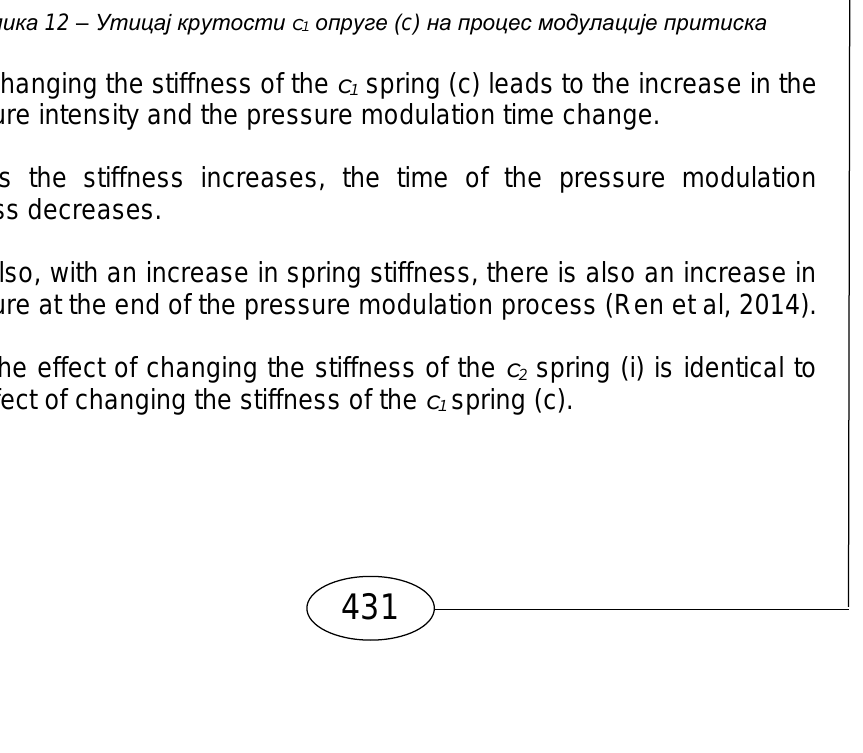
Figure 12 – The influence of the stiffness of the c 1 spring (c) on the pressure modulation process Рис. 12 – Влияние жесткости пружины c 1 (c) на процесс модуляции давления Слика 12 – Утицај крутости c 1 опруге (c) на процес модулације притиска